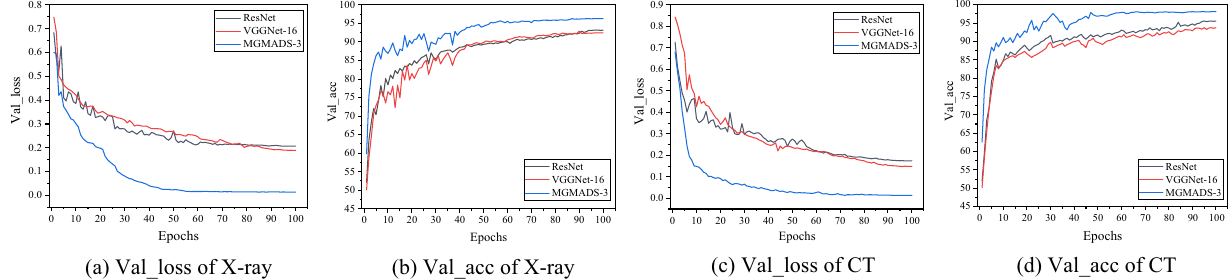
Figure 9. Val_loss and Val_acc curves of X-ray and CT images.